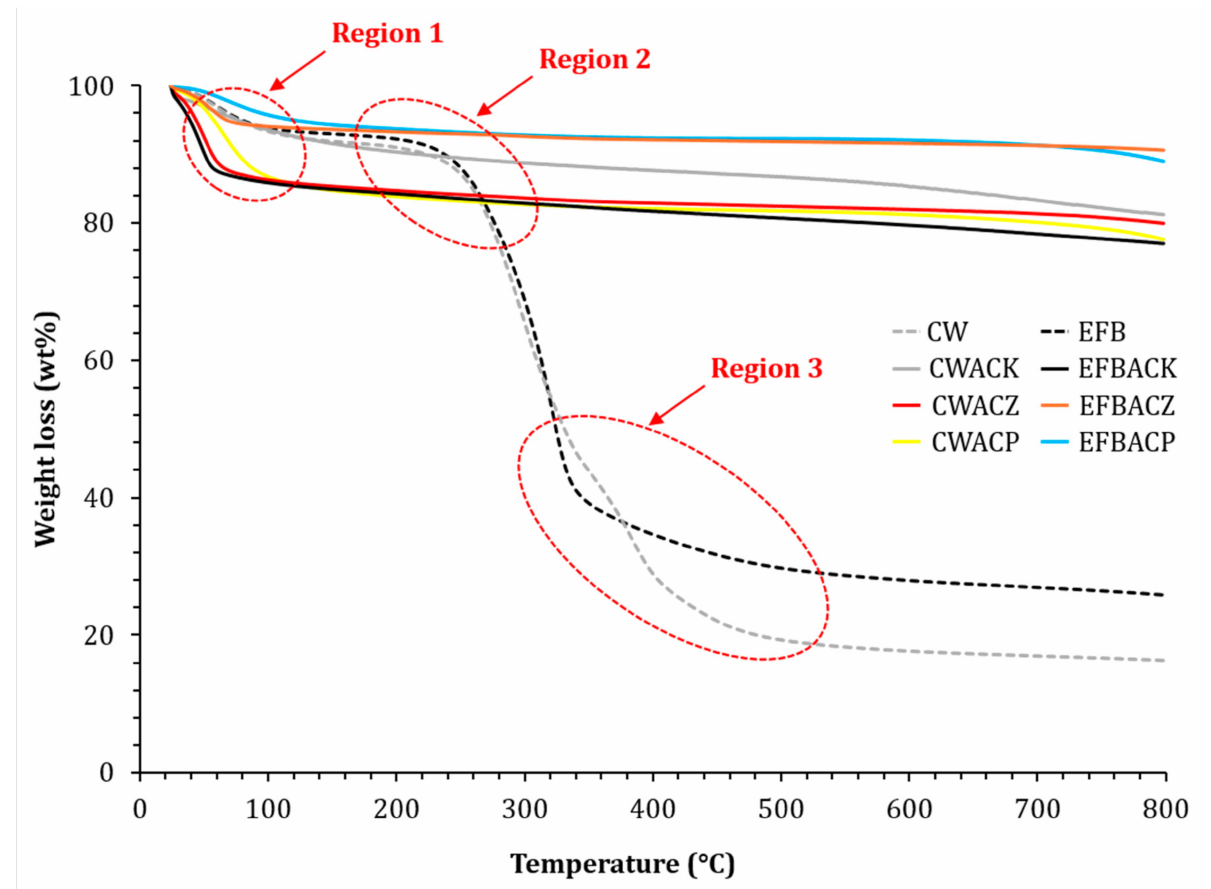
Figure 4. Thermal degradation for biomass feedstock and activated